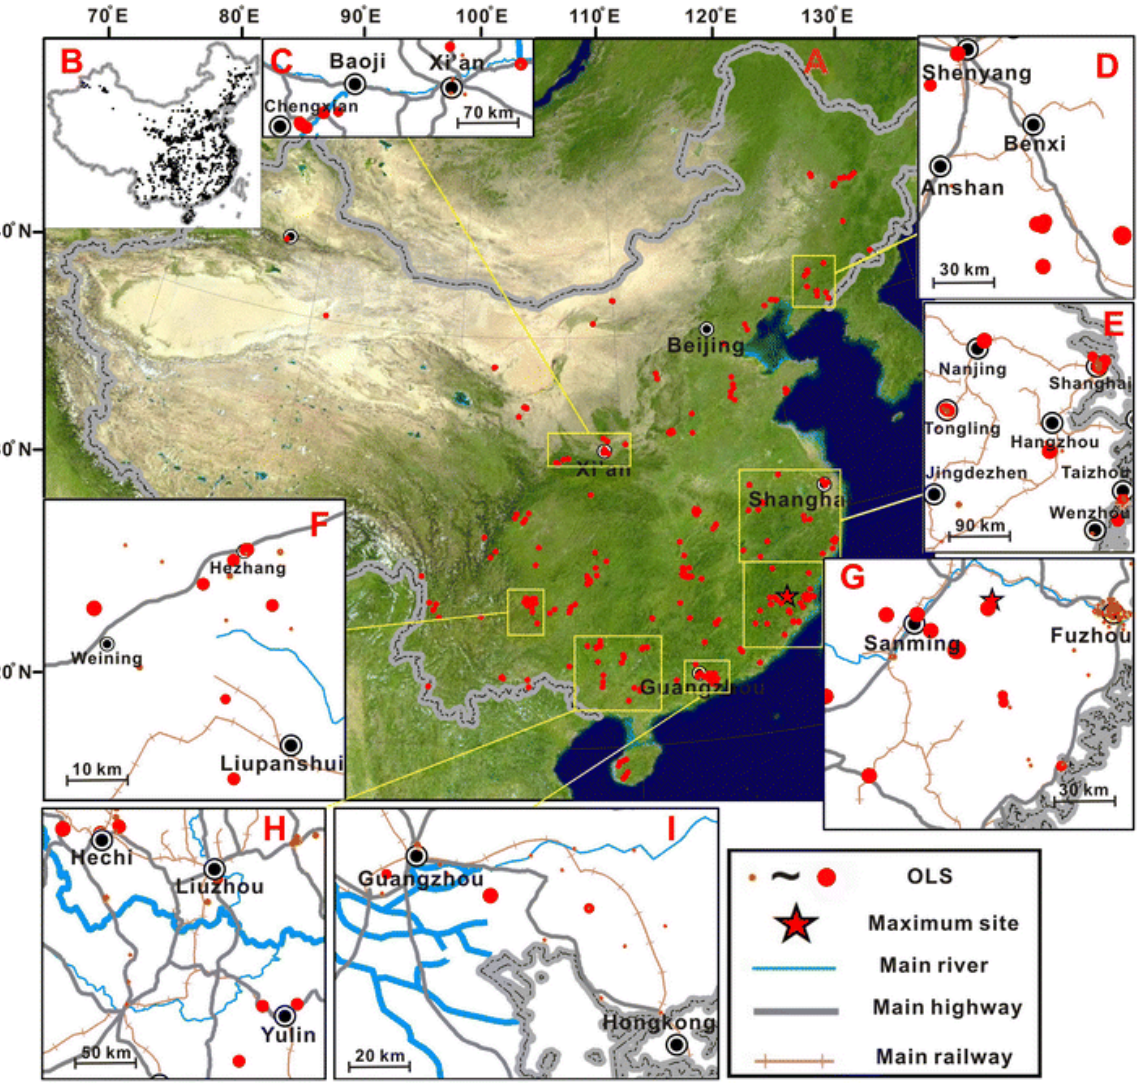
Fig. 2. China’s distribution of lead Over Limit Sites (OLSs) (A); Distribution of lead sampling sites (B-I) (Source: Duan et al., 2016) Note: In (C) (D) (E) (F) (G) (H) and (I), Over Limit Sites (OLSs, red dots) were grouped into 4 classes: 1–3, 3–5, 5–10, and >10 according to the multiples of the limit value (Lead: 80